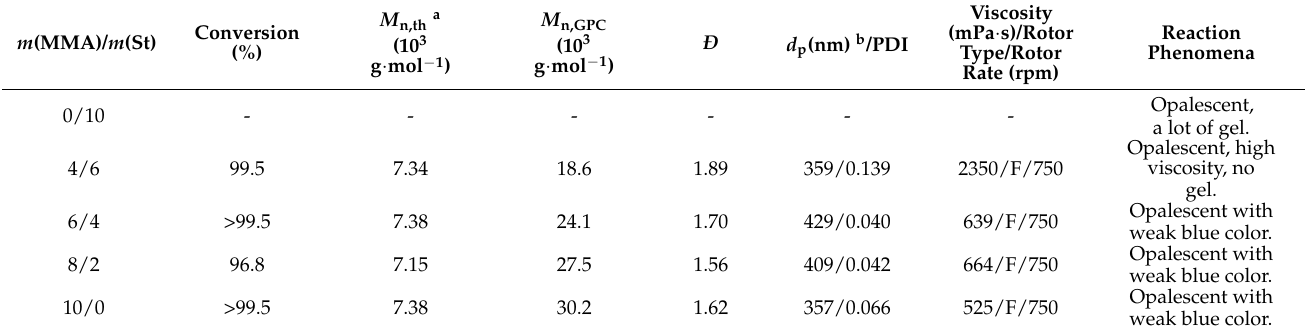
Opalescent with weak blue color.